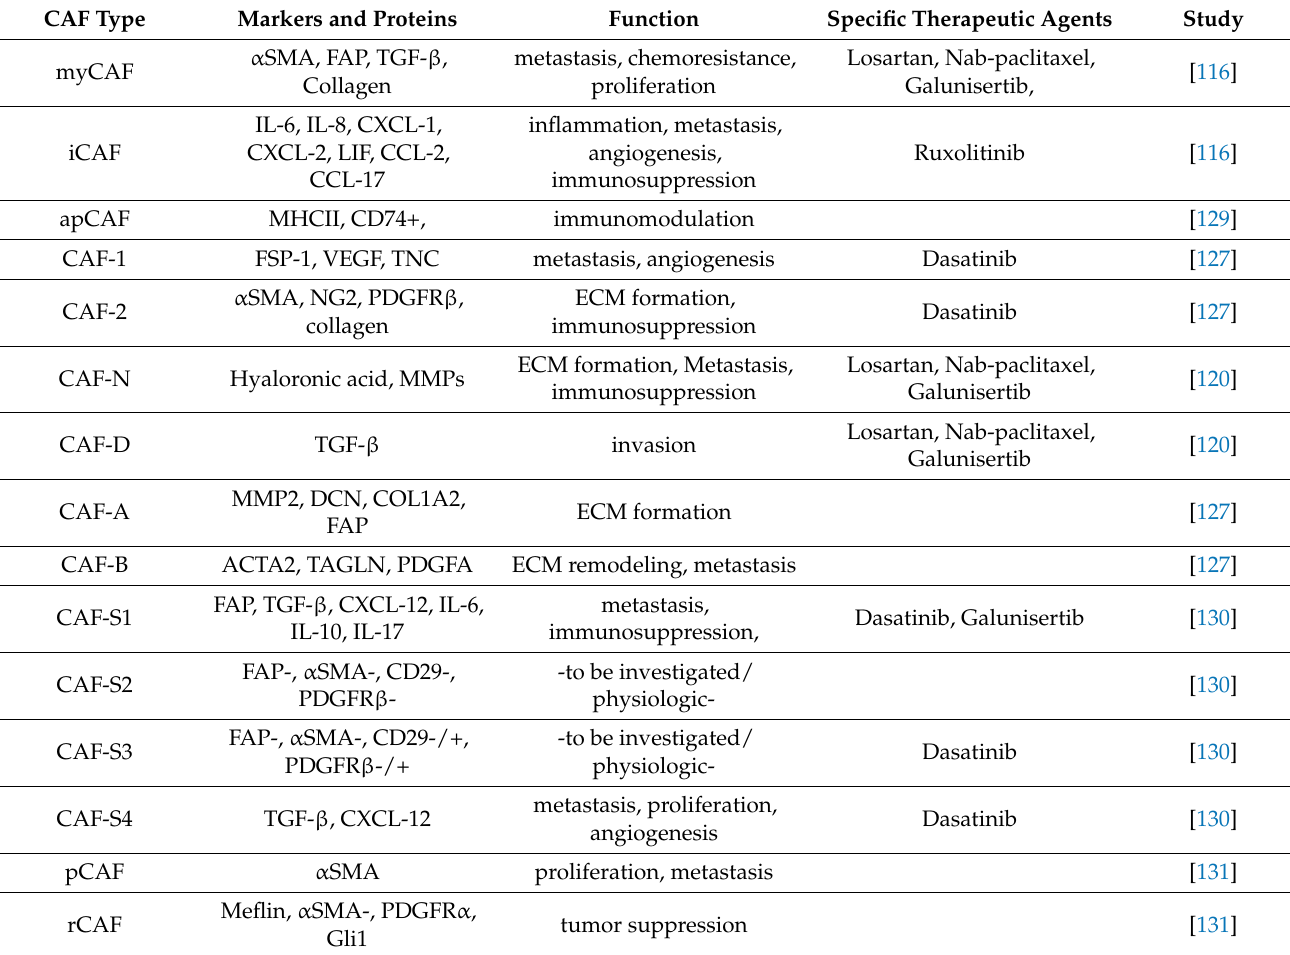
Table 1. Summarizes different subtypes of CAFs that have been described by different studies. At this point, the interrela- tionship between different CAF subtypes and whether there are overlying phenotypes is not